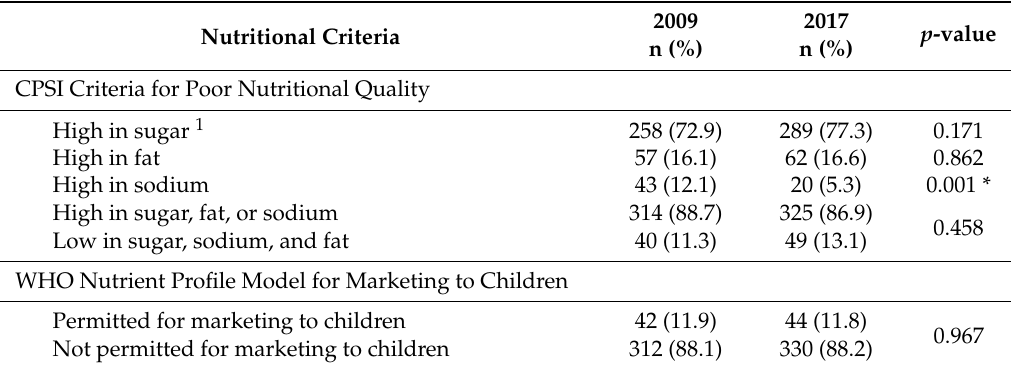
Table 2. Comparison of the nutritional value of children’s food products from 2009 and